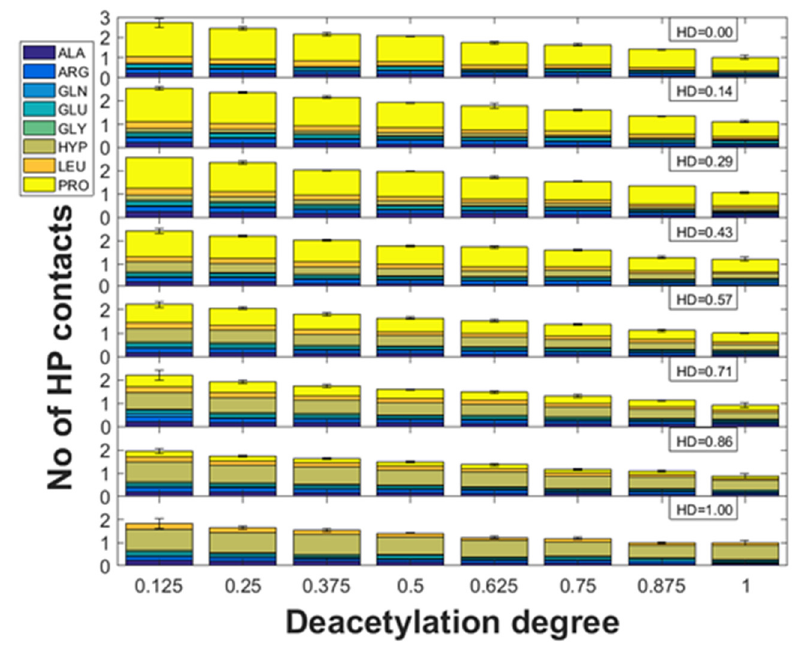
Figure 5. Number of hydrophobic (HP) contacts vs. chitosan DD for different HD of collagen.